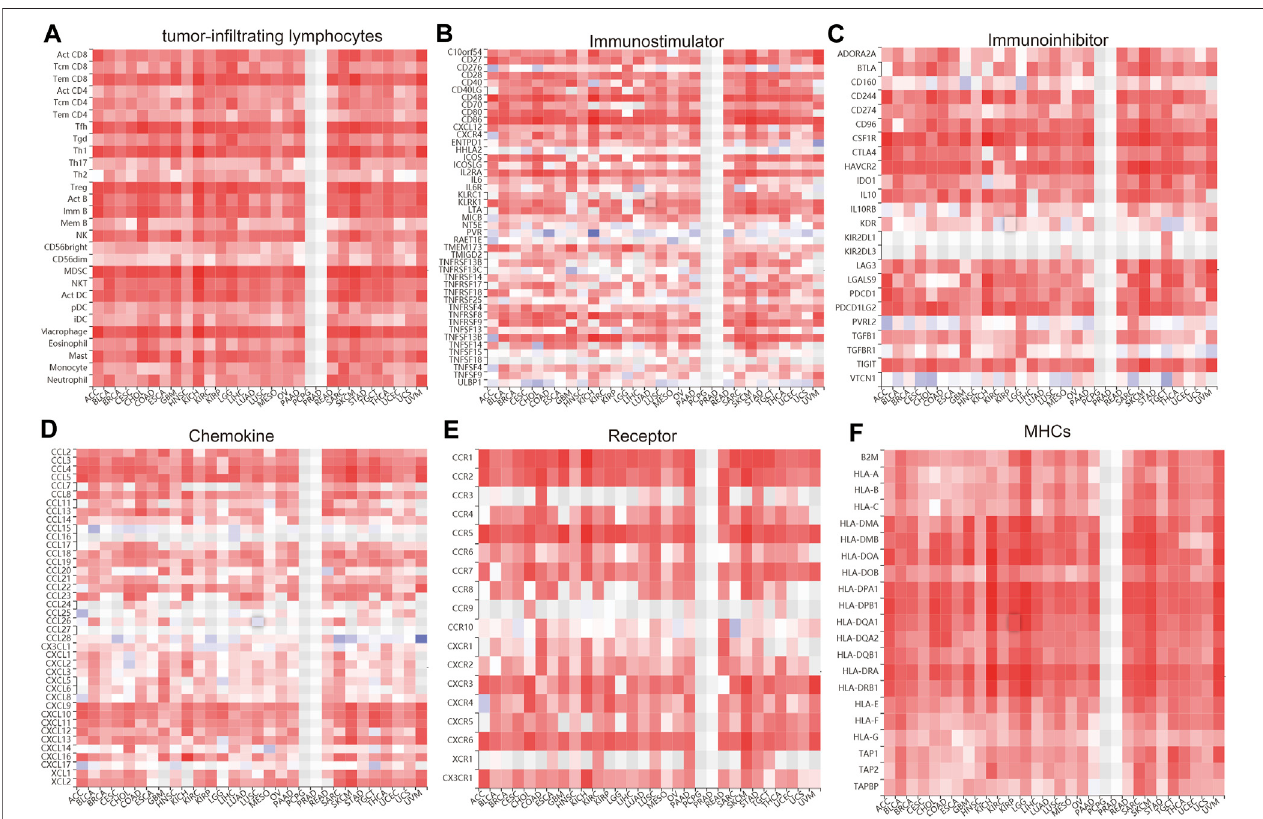
FIGURE 11 | Analysis of the correlation between the IQGAP3 expression and diverse immune regulators. (A) The correlation between the IQGAP3 expression and 28 tumor-in fi ltrating lymphocytes was analyzed in pan-cancer by using the TISIDB database. (B) The correlation between the IQGAP3 expression and 45 immune stimulators in pan-cancer was examined by using the TISIDB database. (C) The correlation between the IQGAP3 expression and 24 immune inhibitors in pan-cancer was examined by using the TISIDB database. (D) The correlation between the IQGAP3 expression and 41 chemokines in pan-cancer was examined by using the TISIDB database. (E) The correlation between the IQGAP3 expression and 18 receptors in pan-cancer was examined by using the TISIDB database. (F) The correlation between the IQGAP3 expression and 21 MHCs in pan-cancer analysis was performed by using the TISIDB